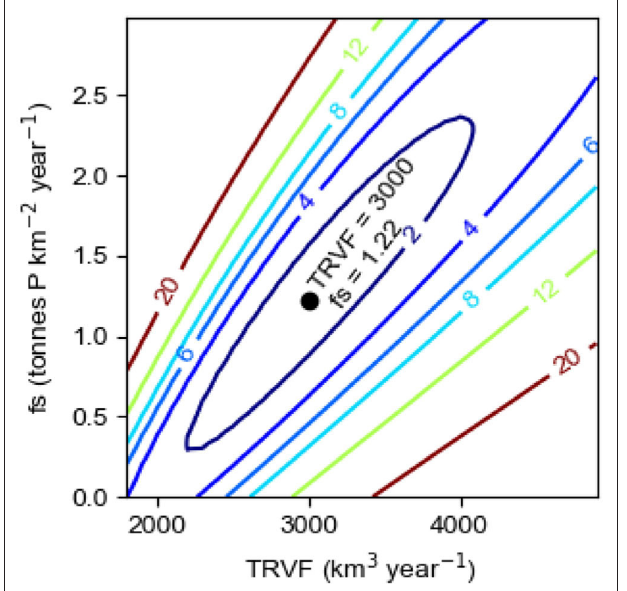
FIGURE 8 | Computational results c1mod from the best fit model with fs = 1.22 tons km − 2 year − 1 and TRVF = 3,000 km 3 year − 1 . Three different initial concentrations c1i were applied. The graphs show the computed concentration c1mod 1950–2014 (black lines) and the observed concentration c1obs 1968–2014 (red line) of phosphorus in the surface layer in